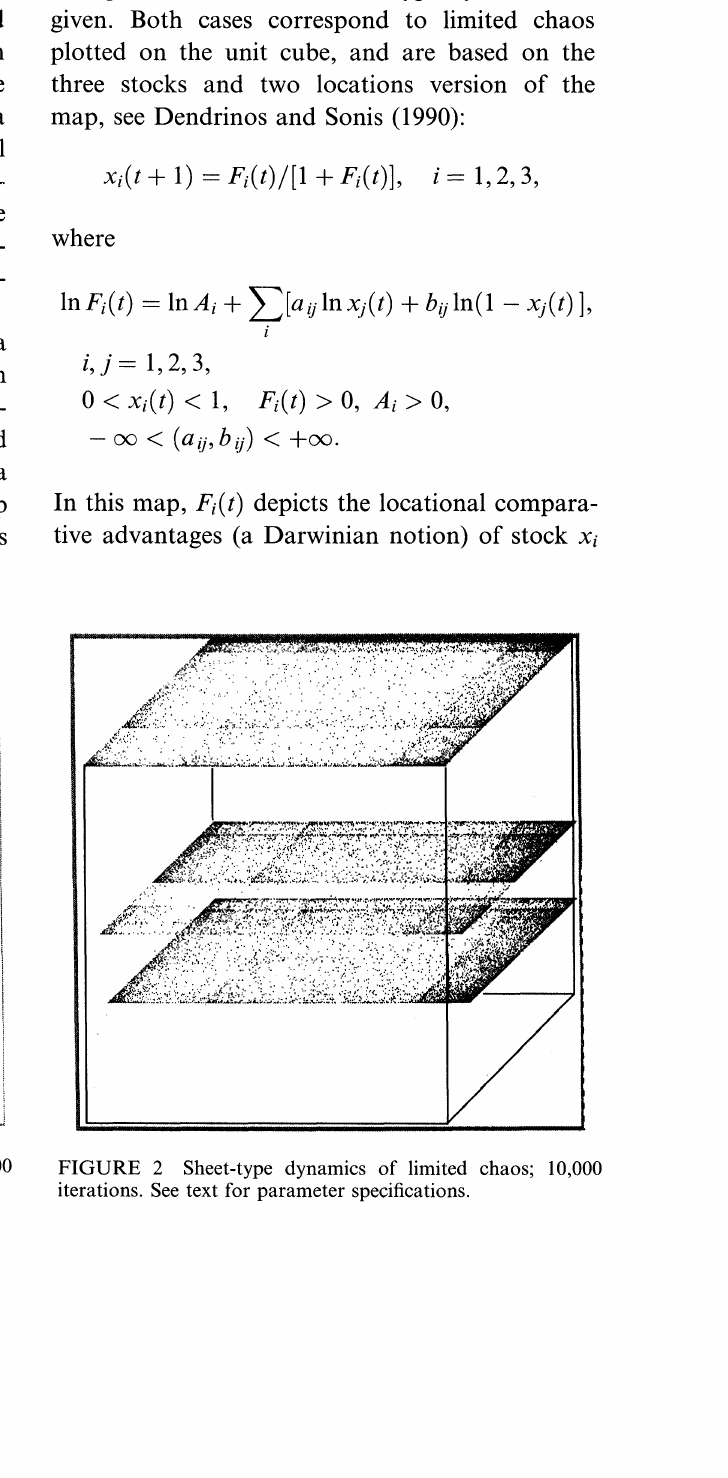
FIGURE 2 Sheet-type dynamics of limited chaos; 10,000 iterations. See text for parameter